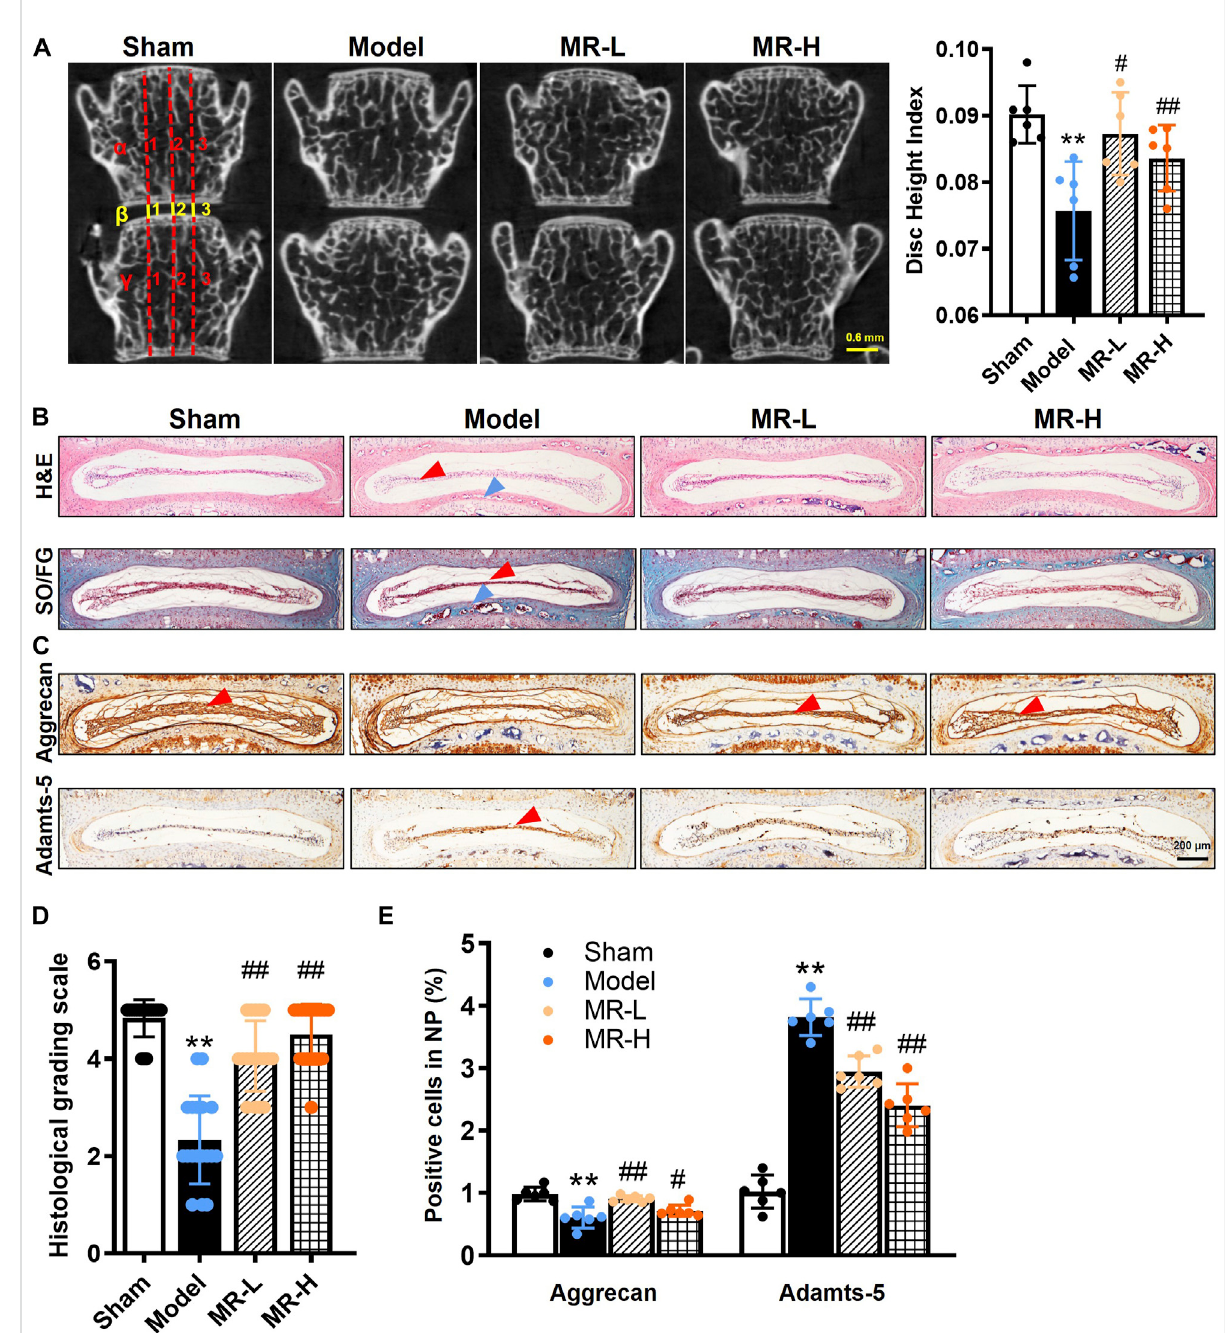
FIGURE 1 MR delays IVDD progression in LSI surgery-induced IVDD mice. (A) Representative micro-CT image of the lumbar spine. From day 3 post-LSI surgery,miceintheMR-LandMR-HgroupswereintraperitoneallyinjectedwithMR(20and100 mg/kgbodyweight,respectively)5timesaweekfor 8 weeks. The DHI between the L3 and L4 vertebrae was calculated based on measurements of adjacent L3 and L4 vertebrae. Yellow lines represent the distances ( β 1- β 3) between the adjacent vertebra, and red lines represent adjacent vertebral body heights ( α 1- α 3 and γ 1- γ 3). DHI was calculatedusingthefollowingequation:DHI=2( β 1+ β 2+ β 3)/( α 1+ α 2+ α 3+ γ 1+ γ 2+ γ 3). (B) H&EstainingandSafraninO/Fastgreenstainingresults ofIVDs.Redarrowheadsindicate fl attened NPtissues, bluearrowheads indicateCEP. (C) TheIHCstainingresults ofAggrecanandAdamts-5 inIVDs. Red arrowheads indicate positive staining cells. (D) Evaluation of IVDD degree by histological grading score. (E) Quanti fi cation of Aggrecan and Adamts-5 in (C) . Data are expressed as mean ± SD, ** p < 0.01 (vs. Sham group); # p < 0.05, ## p < 0.01 (vs. IVDD group), n = 10 per